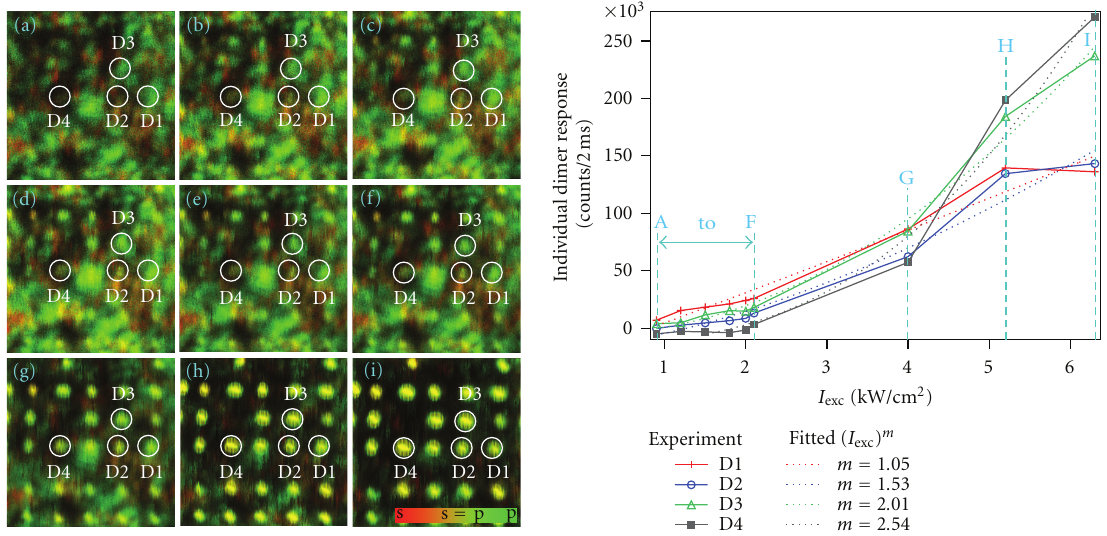
Figure 9: Femtosecond pulsed excitation over gold dimers. The excitation wavelength is fixed at 565 nm, and its power density is varied from 0.9 (a) to 6.3 kW/cm 2 (i). The dedicated sample here is a 100 × 100 μ m array of dimers with a 100nm diameter, a 30 nm gap, and a 60 nm thickness, that matches the excitation wavelength. A 50nm layer of perylene in PMMA is spin-coated over the gold dimers as in Figure 4(a). The graph displays the individual response of selected dimers (circled on the image series) as a function of the excitation power. From one dimer to another, one can see various power dependences of the signal, going from close to linear behavior (for D1) to overquadratic one (in D3 and